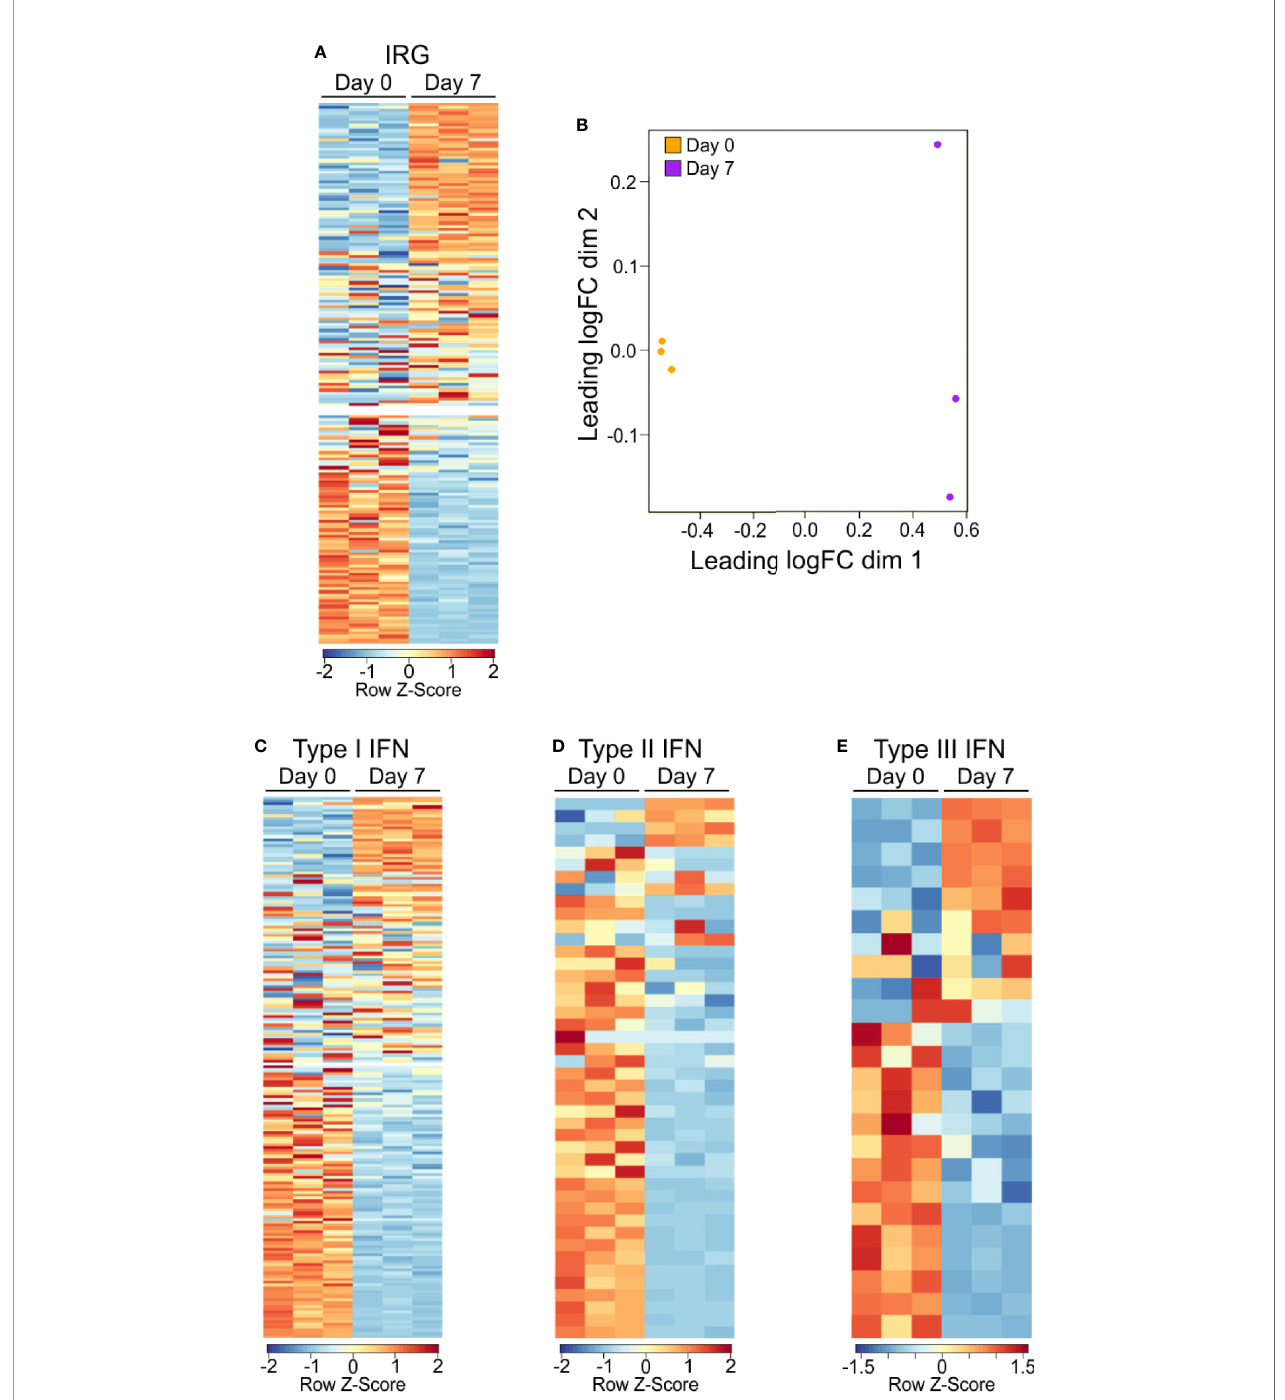
FIGURE 2 | Gene expression IRG signature of PSA exposed cells. (A) Heat map of interferon responsive genes from PSA exposed (D7) or unexposed (D0) CD4 + T cells. Values are row z-score. (B) Multidimensional scatterplot of IRG data comparison of PSA exposed and non-exposed cells (D7 in orange, D0 in purple). (C) Breakdown of IRG list into Type I, Type II, or Type III IFN